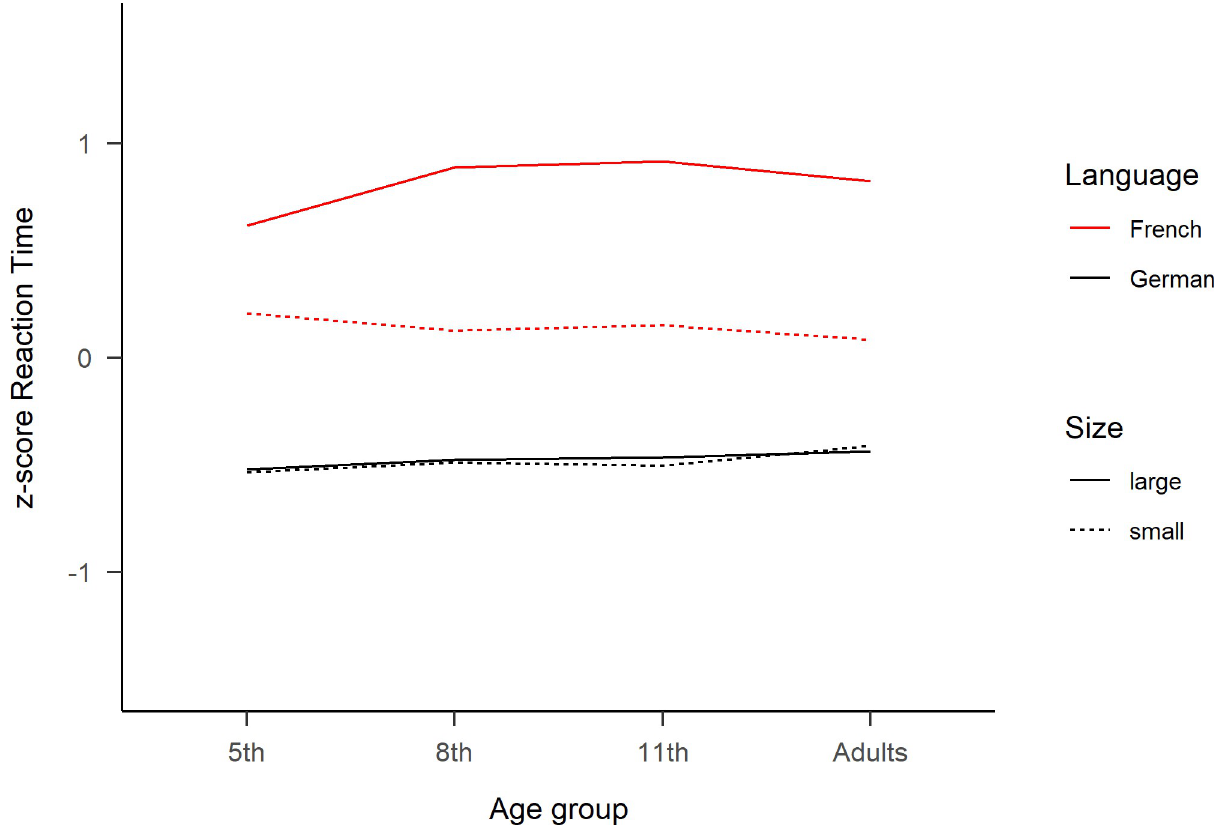
Fig 3. Z-score reaction times of the reading aloud task. Standardized reaction times for each age group as a function of “Language” and “Number Size”. Large numbers correspond to ‘70s, ‘80s and ‘90s, while small numbers correspond to ‘30s, ‘40s and ‘50s.